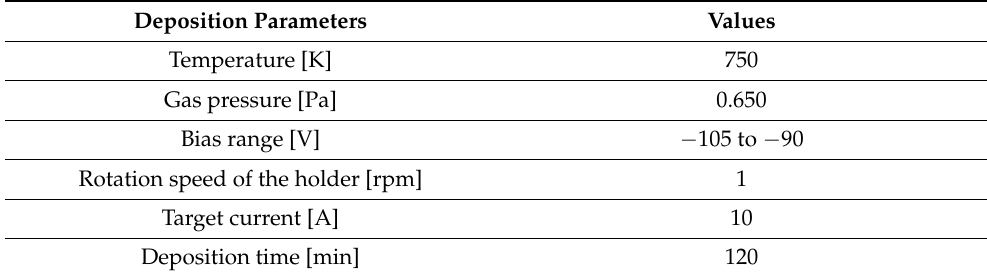
Figure 2. Alumina powder particles size distribution.